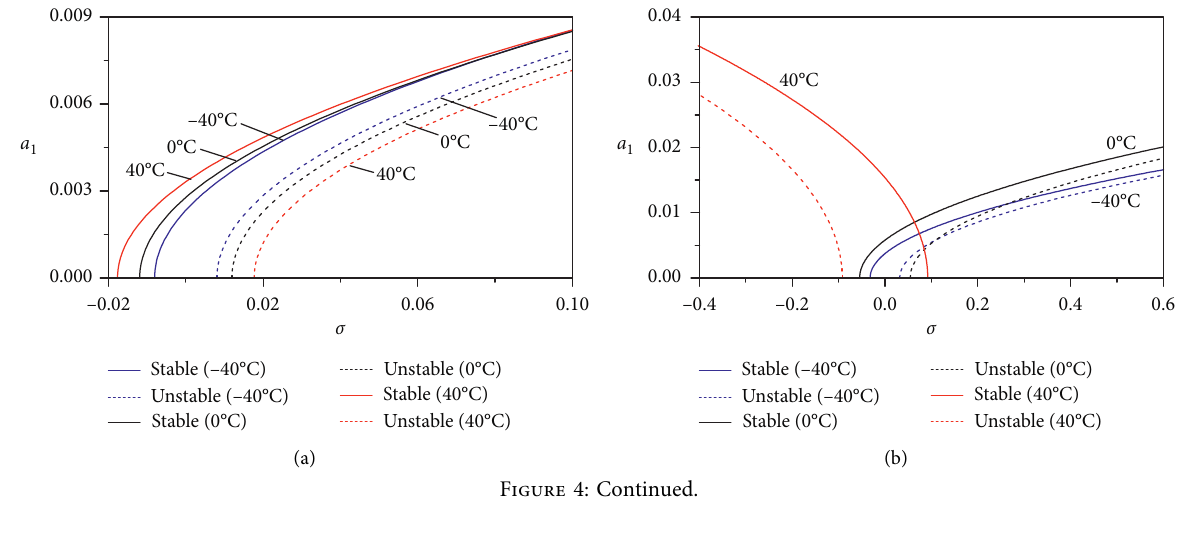
Figure 3: Temperature effects on relationships between excitation amplitude K (a) f � 0 . 0025, (b) f � 0 . 006, (c) f � 0 . 010, and (d) f � 0 .